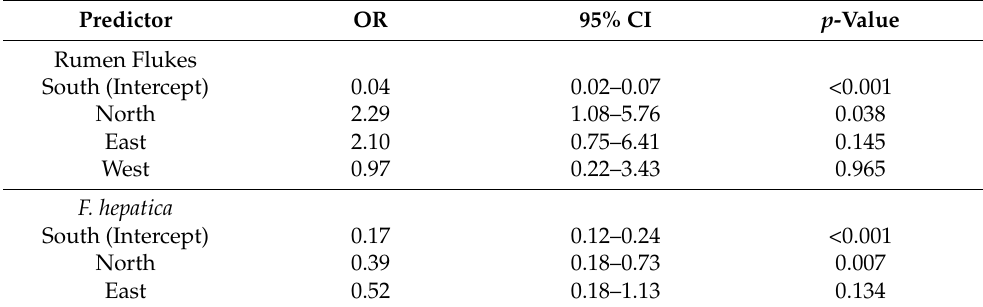
Table 2. Odds ratio, 95% confidence interval and p -value for rumen fluke and F. hepatica prevalence per German region. Note that in the region West no F. hepatica positive samples were